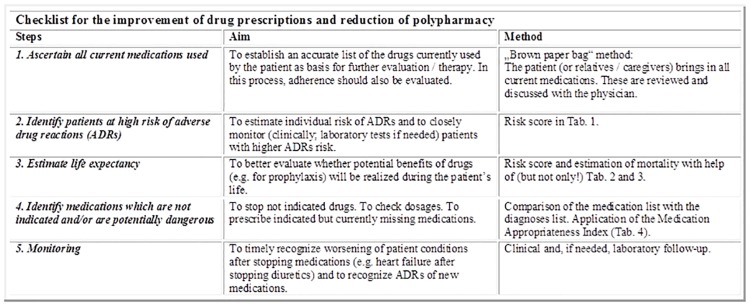
Checklist, page 1.